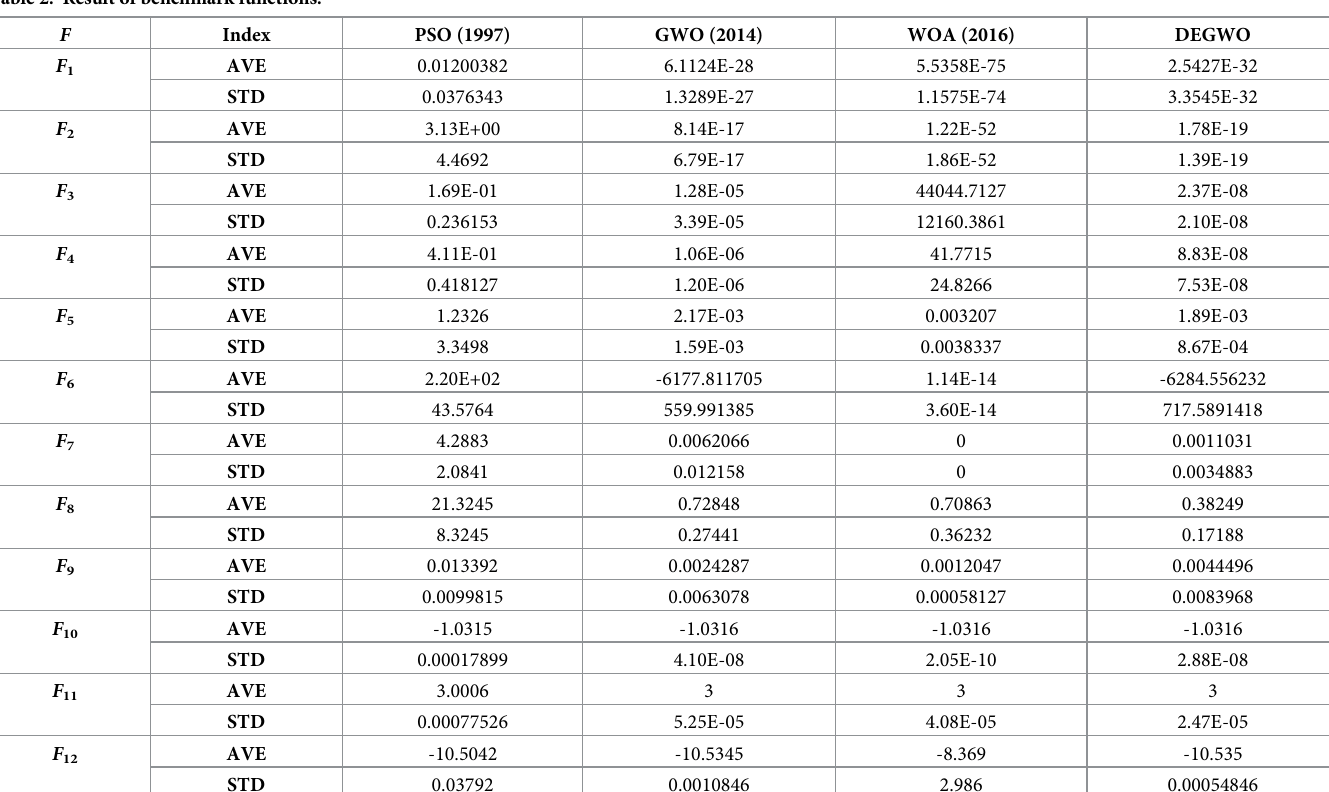
Table 2. Result of benchmark